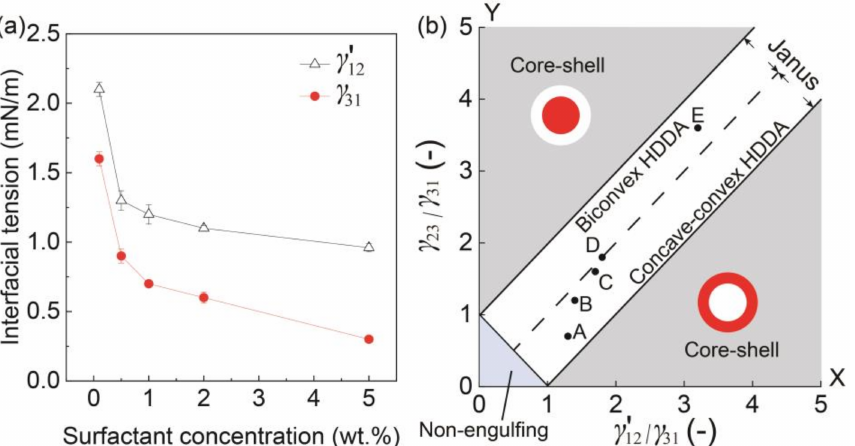
Figure 4. Morphology in response to interfacial tension. ( a ) Surfactant concentrations in silicone vs. interfacial tensions γ (cid:48) 12 and γ 31 . ( b ) Phase diagram showing the relation between the ratio of interfacial tensions γ (cid:48) 12 / γ 31 and the morphologies of the biphasic droplets when Q m / Q s = 1. Inset points of A to E correspond to the results in Figure